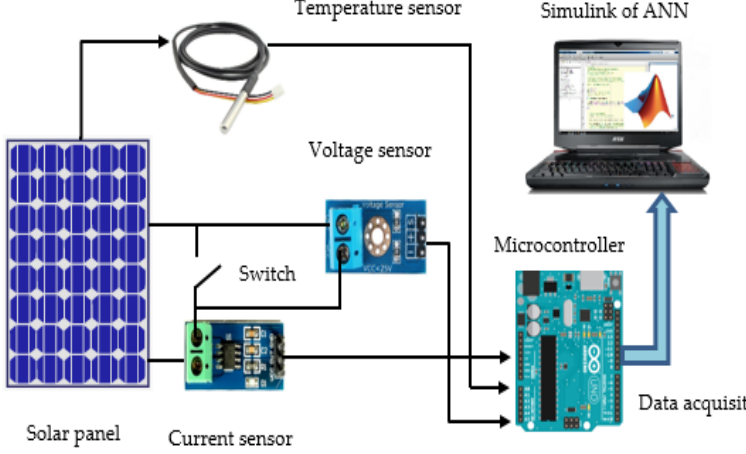
Figure 4. Block diagram of the proposed method.